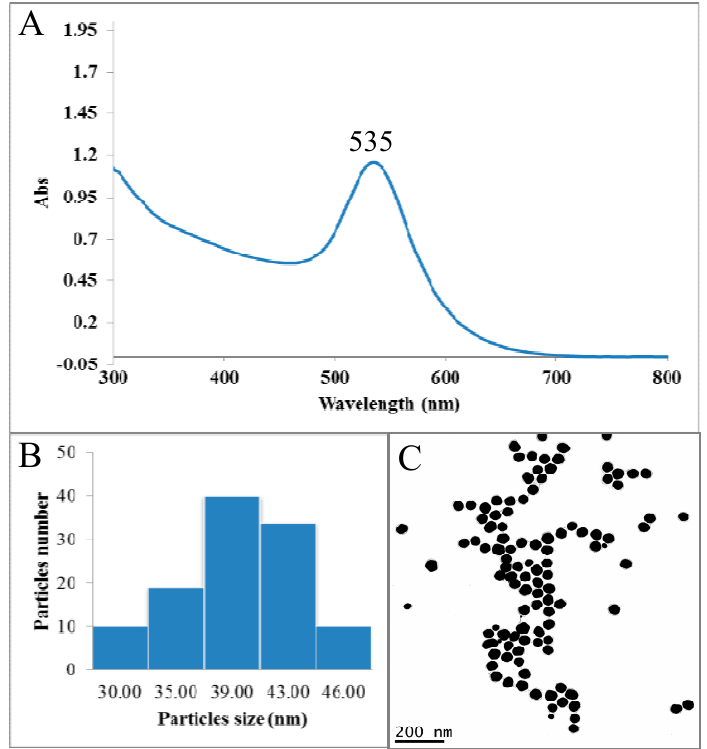
Figure 1. ( A ) UV–Vis absorption spectra of epigallocatechin-3-gallate conjugated gold nanoparticles (EGCg-AuNPs); ( B ) Size distribution histogram of gold nanoparticle solution; ( C ) Metallic core size of AuNPs by transmission electron microscopy. Table 1. Physicochemical parameters of epigallocatechin-3-gallate (EGCg)-coated-gold nanoparticles (EGCg-AuNPs).